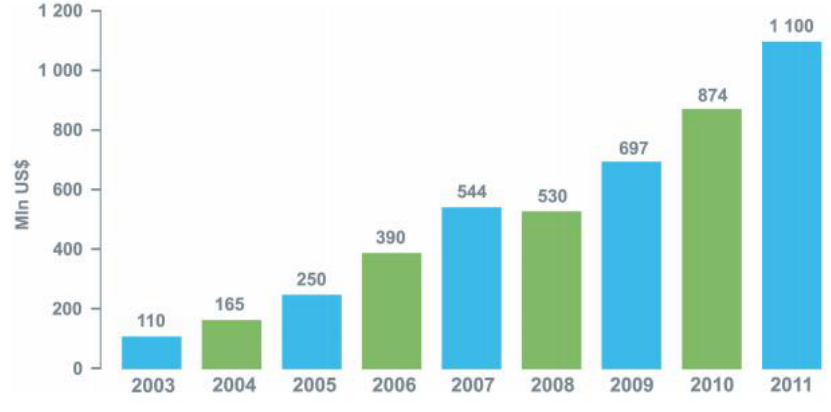
Figure 1. The value of IT outsourcing services provided by Ukraine between 2003 and 2011